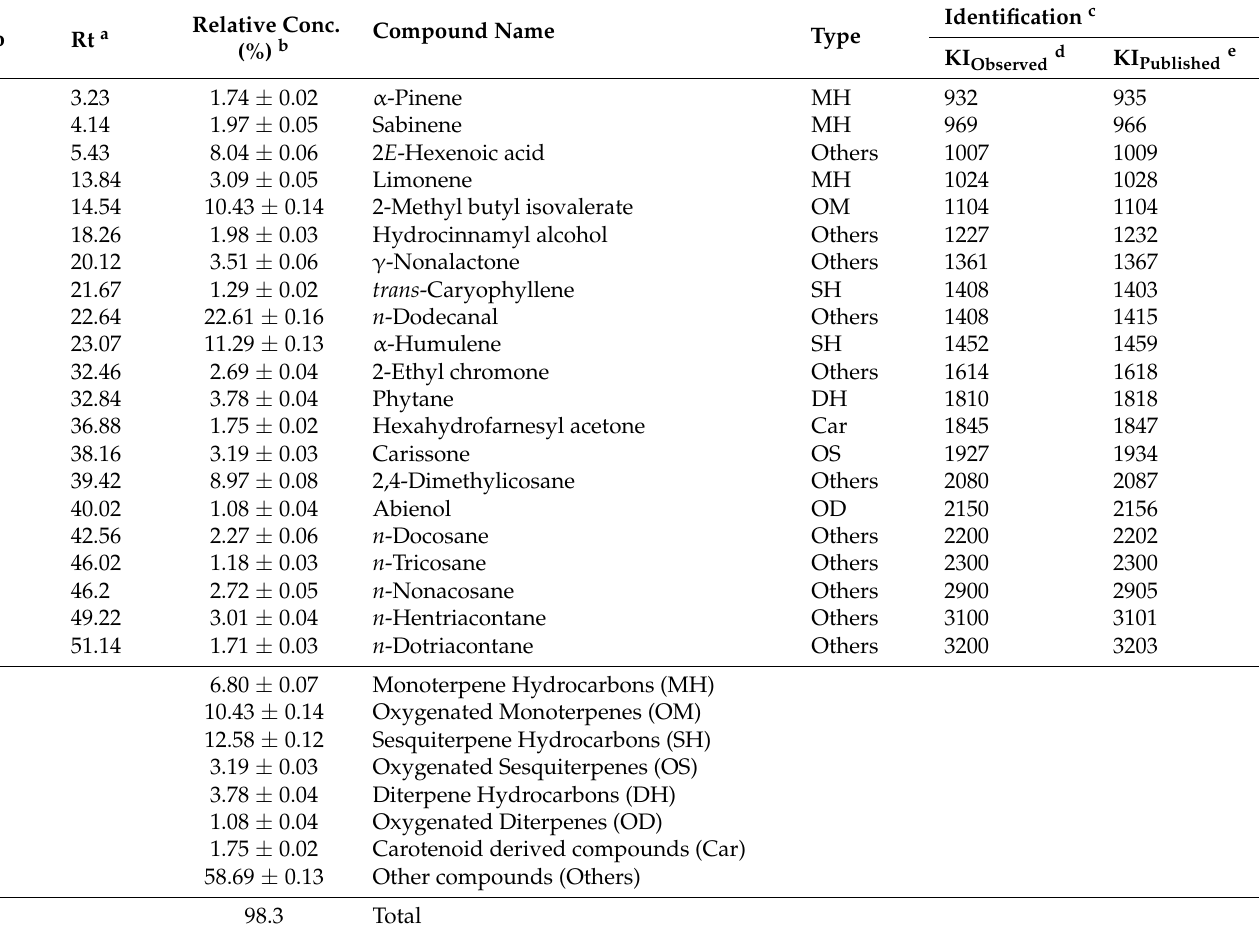
Table 1. Essential oil chemical composition from aerial parts of Persicaria lapathifolia